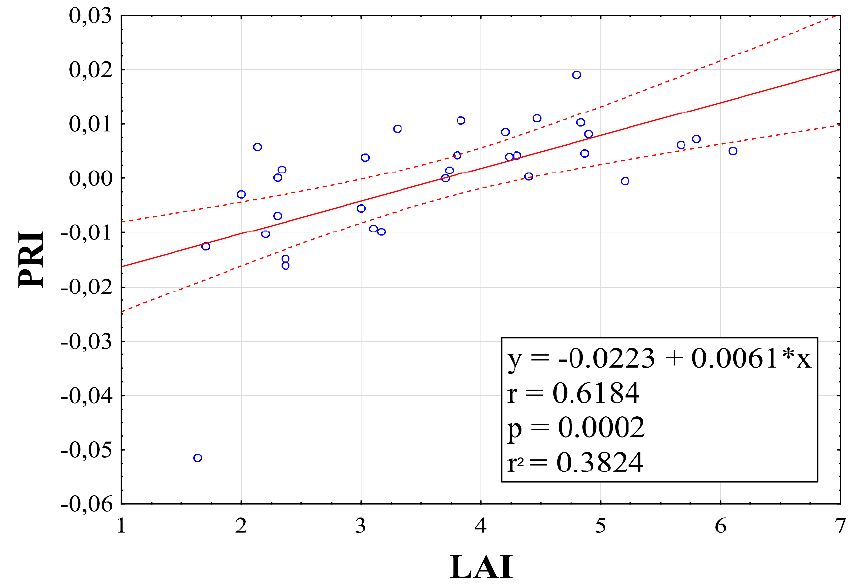
Figure 10. Relationship between leaf area index (LAI) and photochemical reflectance index (PRI). Linear equations, correlation coefficient, probability and regression are inserted inside graphs.